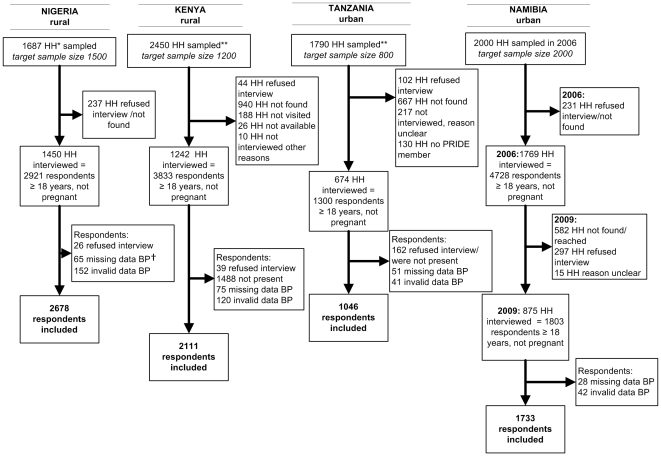
Participation in the 4 surveys (household and individual level).*HH  =  households, **Repeating sampling done because household were difficult to locate due to poor registries used for sampling, †BP =  blood pressure.